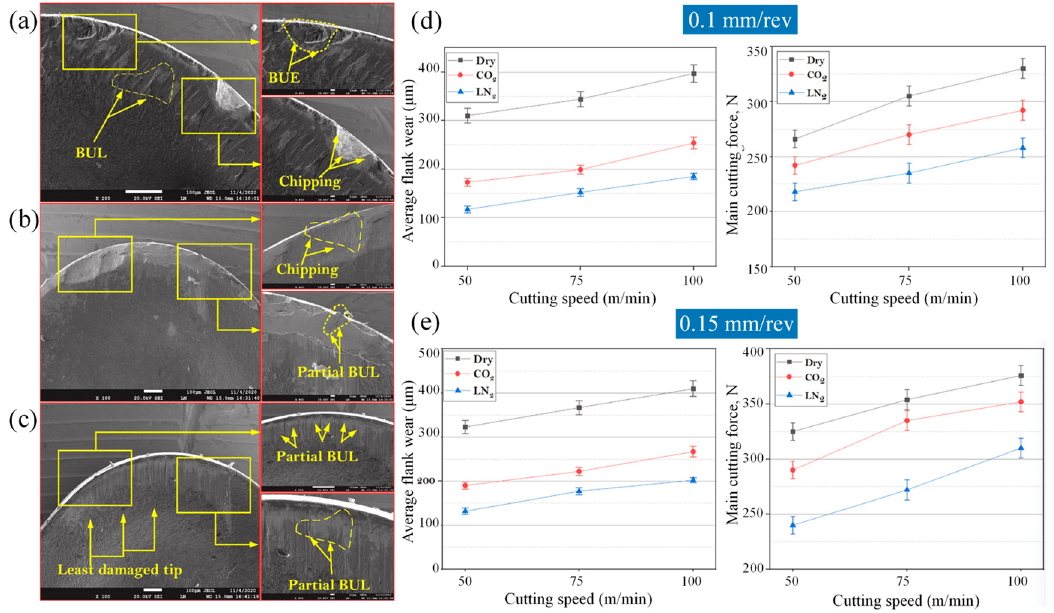
Figure 24. SEM analysis of tool wear under different cooling strategies: ( a ) dry machining. ( b ) CO 2 . ( c ) LN 2 . The built-up-edge (BUE) and chipping appear on the dry cutting tool surface. CO 2 -assisted machining eliminates the formation of BUE, and some sticking in the form of BUL occurs on the rake face. The tool surface under LN 2 -assisted machining is relatively smooth, with a small amount of BUL. ( d ) Average flank wear and main cutting forces at feed rate of 0.1 mm/rev. ( e ) Average flank wear and main cutting forces at feed rate of 0.15 mm/rev, adapted with permission from Ref. [161] 2021, Elsevier. The average flank wear and main cutting force were the lowest with LN 2 -assisted machining.